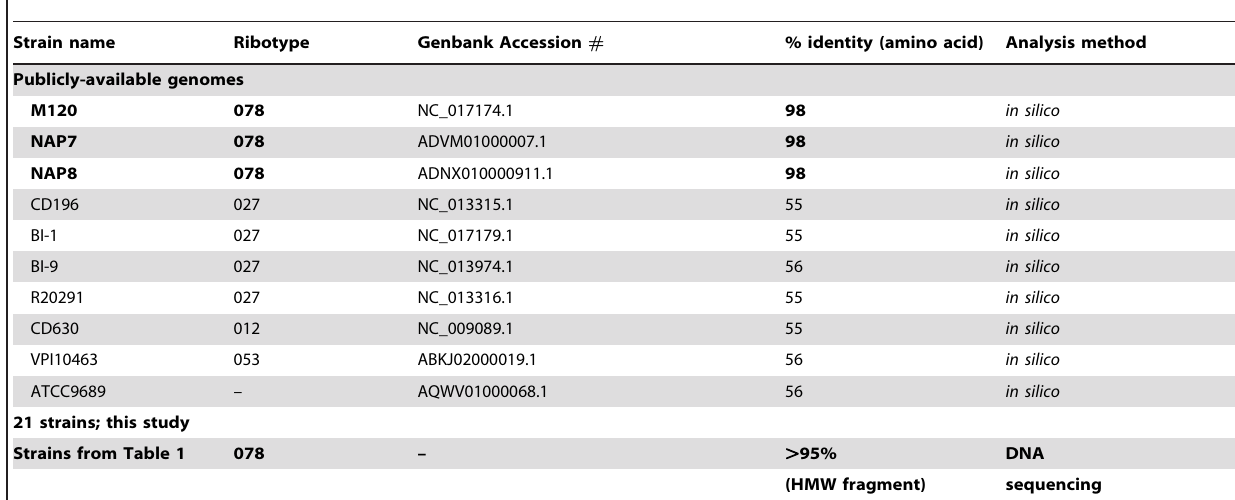
Table 4. SlpA conservation in ribotype 078 C. difficile strains; comparison with non-ribotype 078 isolates.